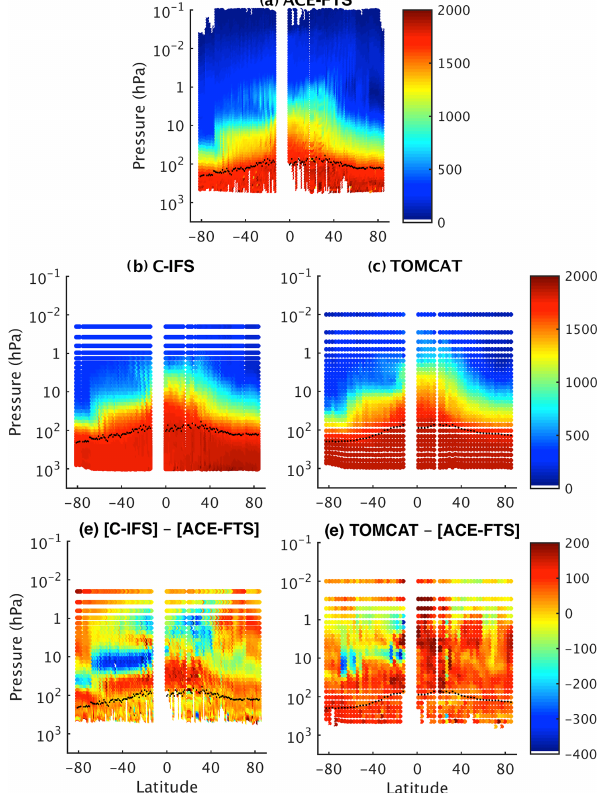
Figure 6. Zonal mean latitude–pressure CH 4 profiles (in ppb) for the months September to November 2010 plotted against latitude. Panel (a) shows the profiles from the ACE satellite soundings. Pan- els (b) and (c) show the profiles from the C-IFS and TOMCAT mod- els, respectively, sampled at the location and time of the ACE mea- surement. Panels (d) and (e) show the bias between the models and ACE measurement. The tropopause location is shown as black